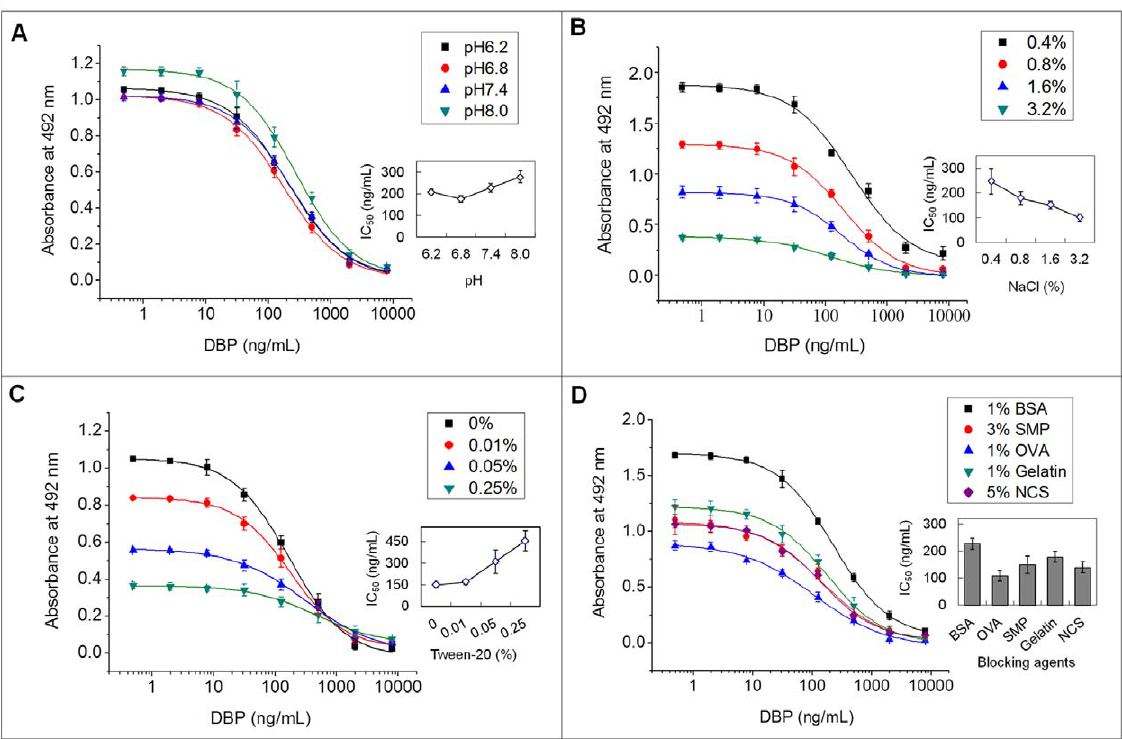
Figure 4. Effects of pH (A), ionic strength (B) and detergent (C) in assay buffer and blocking reagents (D) on icELISA for DBP. Each point represents the mean of 6 SD of three replicates (three plates on the same day).